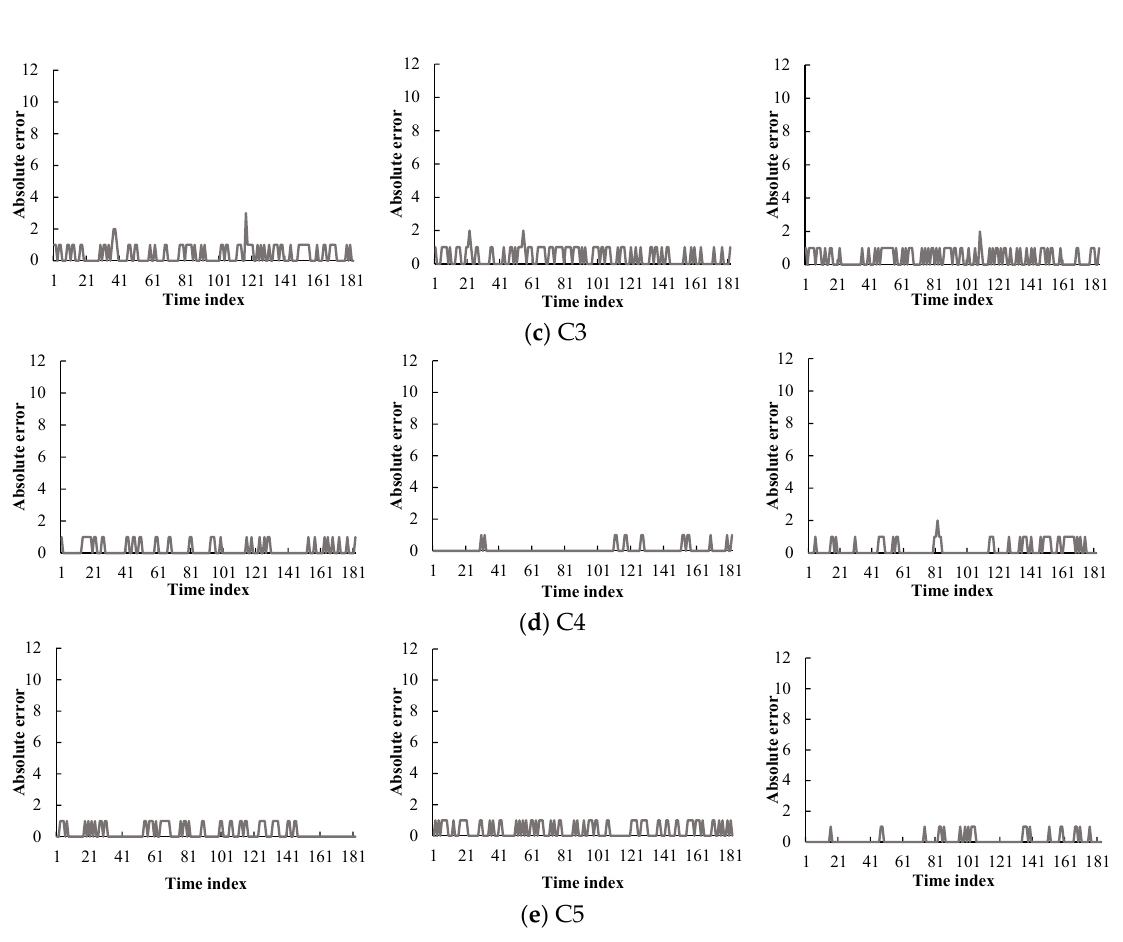
Table 2. Accuracy of the traffic flow prediction (%).